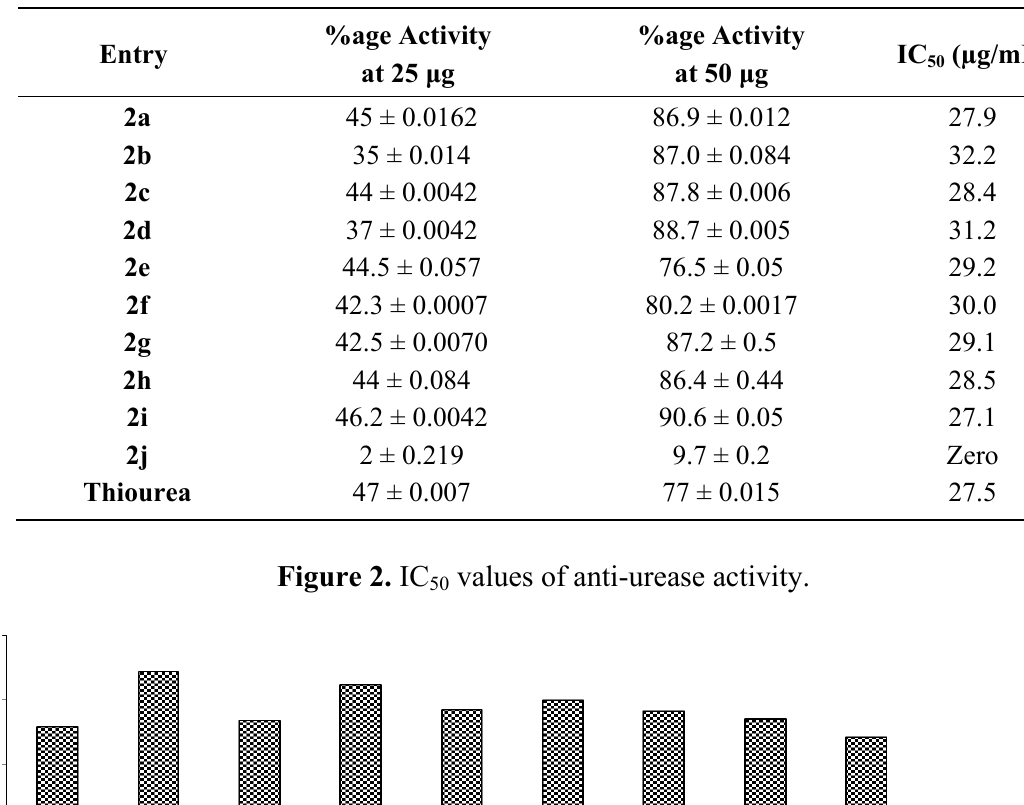
Table 4. Antiurease activity of synthesized compounds.